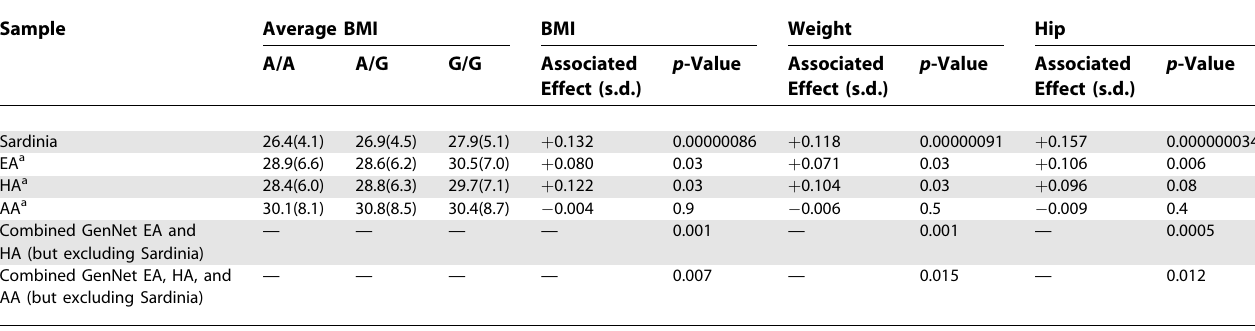
Table 3. Replication of Association between rs9930506/ FTO /G Allele and Obesity-Related Traits